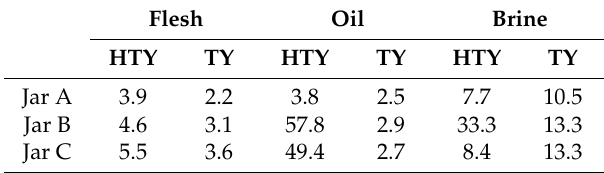
Table 3. N-fold increase of hydroxytyrosol (HTY) and tyrosol (TY) in the di ff erent fractions (flesh, oil and brine) at the end of the de-bittering process, with respect to the initial concentration. Flesh Oil Brine HTY TY HTY TY HTY TY Jar